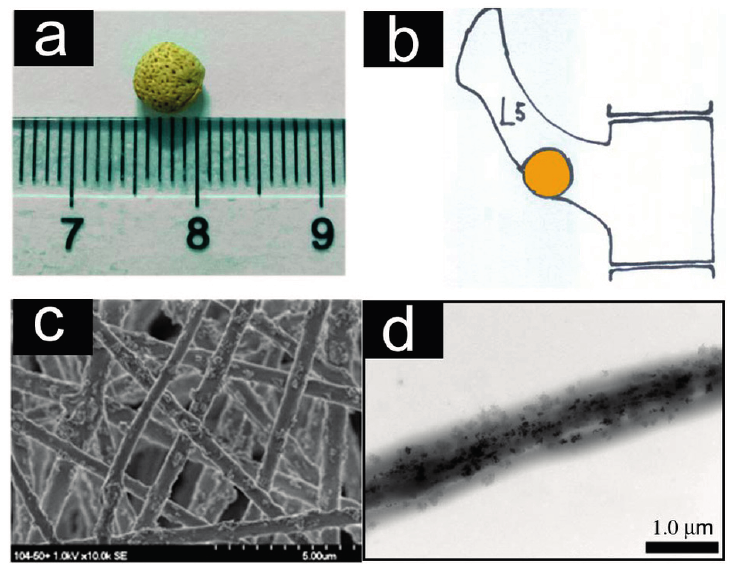
Figure 1. Characterization of the super-paramagnetic nanofibrous scaffolds. ( a ) The scaffold pellet with diameter of ~5 mm; ( b ): Schematic representation of the scaffold pellet implanted into the lumbar transverse defect of a white rabbit lumbar vertebral segment L5; ( c ) SEM image of the scaffold showing randomly tangled nanofibers with diameters ranging from 300 to 1000 nm; and ( d ) The TEM image of a single fiber. Reprinted with permission from